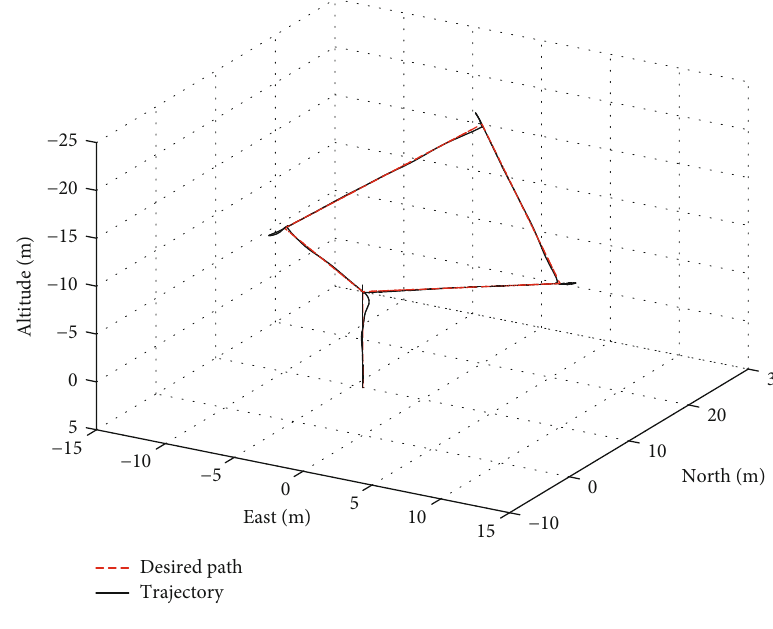
Figure 8: 3D trajectory of the SUAV.